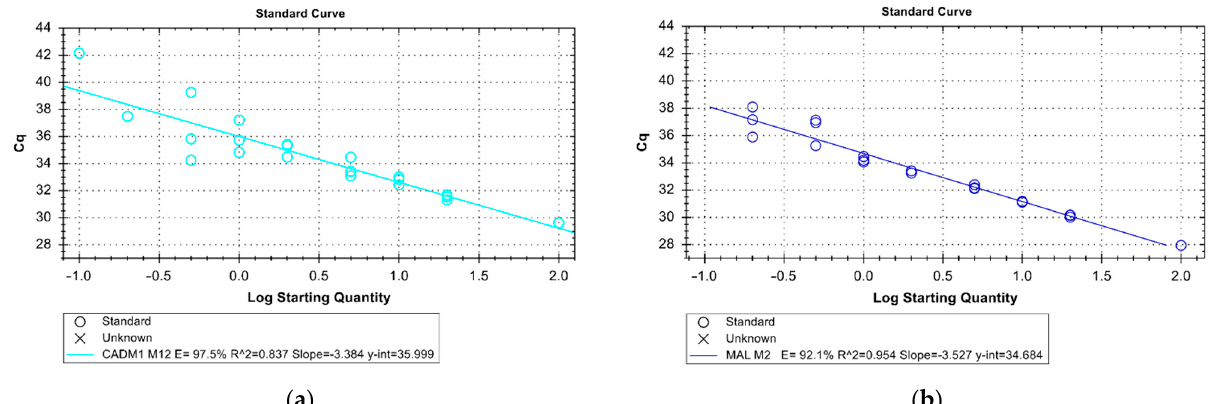
Figure 1. Dilution series of the CADM1 ( a ) and the MAL ( b ) qMSP for assessing the sensitivity and efficiency of the assay. The x -axis indicates the starting concentration of fully methylated DNA diluted in unmethylated DNA in percent on a logarithmic scale by a total DNA input of 10 ng. Triplicate analyses were performed for each dilution except for 100%. The y -axis shows the Cq at which the threshold value was exceeded (Ct-value). For CADM1, an efficiency of PCR of 97.5%, detection of methylated DNA down to 0.1% is possible. For MAL an efficiency of PCR of 92.1%, detection of methylated DNA down to 0.2% is ensured.